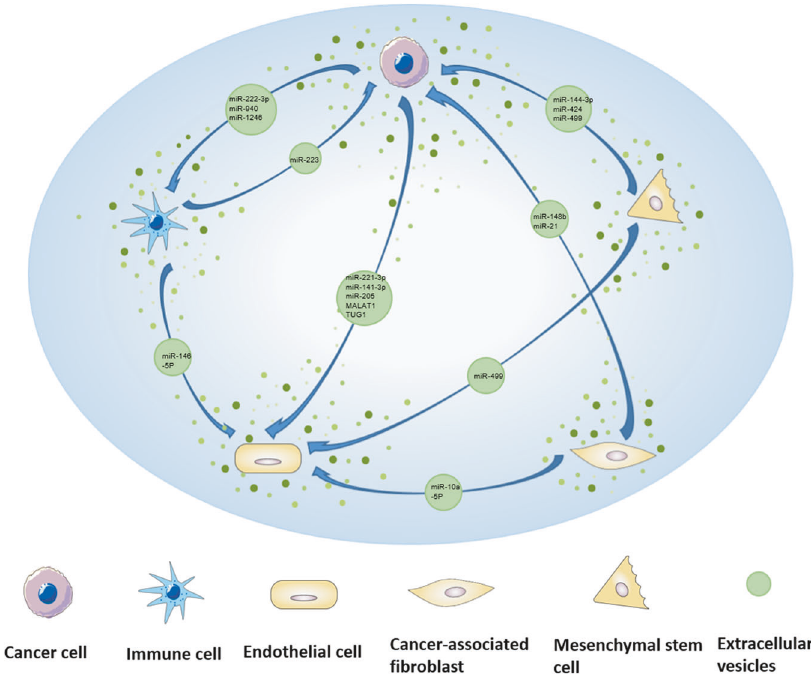
Fig. 2 EV ncRNAs mediate the communication between cancer cells and stromal cells in TME of gynecological malignancies. ncRNAs derived from cancer or stromal cells are packaged in EVs are shuttled among cancer cells and different stromal cells, remodeling TME and contributing to the cancer development and